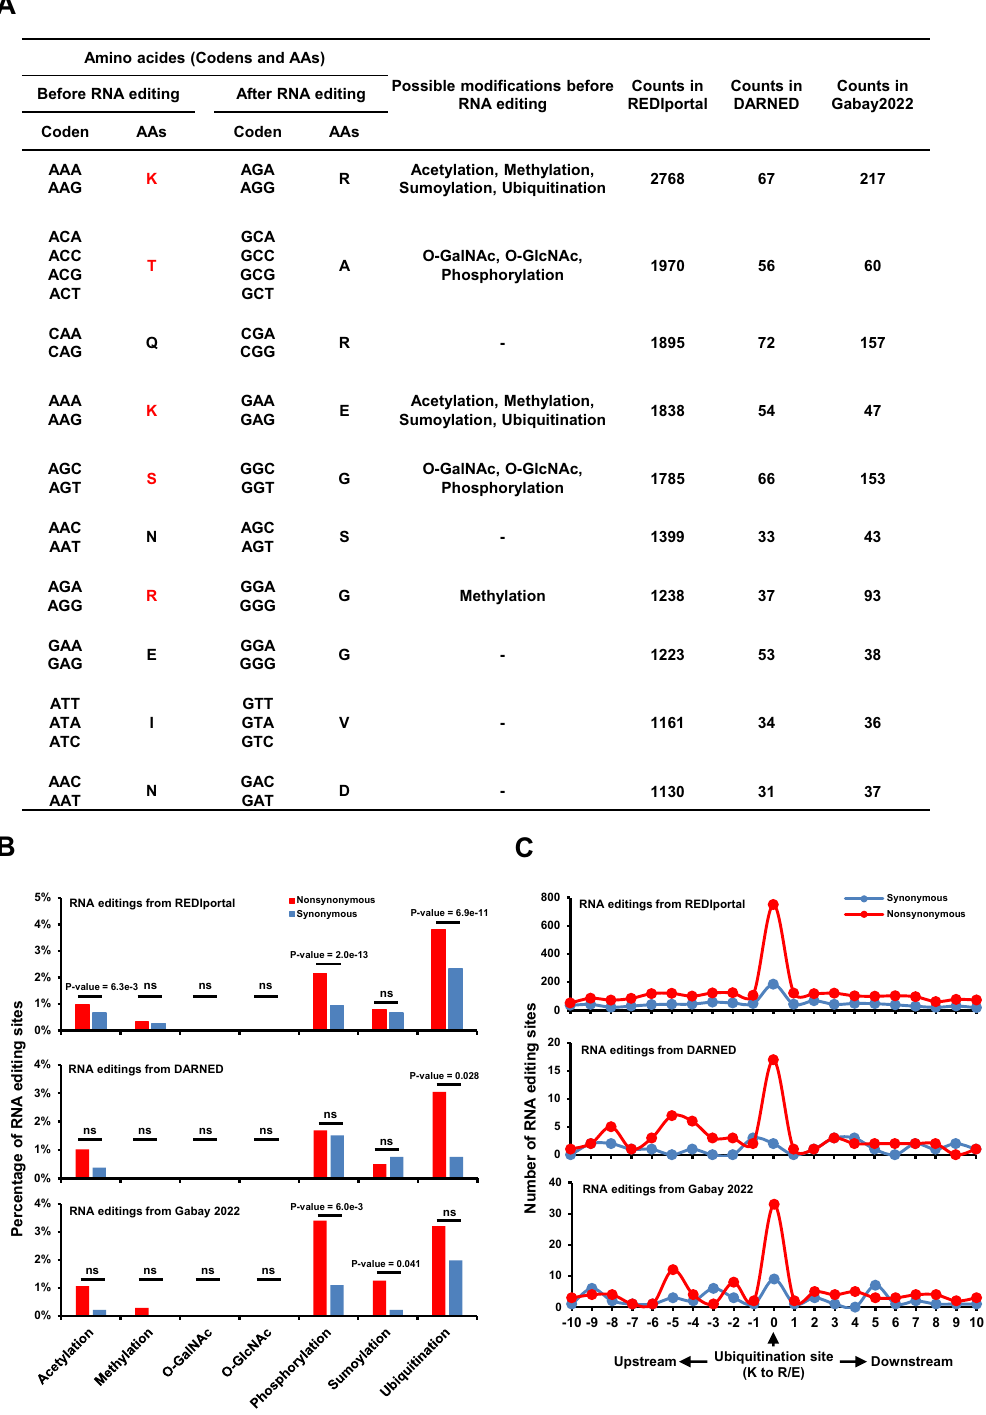
Figure 1. Overlaps between RNA editings and protein modification sites. ( A ) Table summarizing the frequency of amino acids (AAs) affected by nonsynonymous RNA editing in three RNA editing databases. ( B ) Bar plot demonstrating the percentage of nonsynonymous RNA editing in three RNA editing databases located in the protein modification sites. The P-value was computed by one-sided “fisher.test” function in R. ( C ) The distribution of synonymous (blue) and nonsynonymous (red) RNA editing from three RNA editing databases on ubiquitination site and flanking regions. ( D ) Venn plotting showed the overlaps between ubiquitination and acetylation sites in PhosphoSitePlus database. ( E ) Bar plot demonstrating the percentage of nonsynonymous RNA editing in REDIportal database located in the ubiquitination unique and acetylation unique sites. The P-value was computed by one-sided “fisher.test” function in R. ( F ) The distribution of synonymous (blue) and nonsynonymous (red) RNA editing from REDIportal database on ubiquitination unique site and flanking regions (upper) and on acetylation unique site and flanking regions